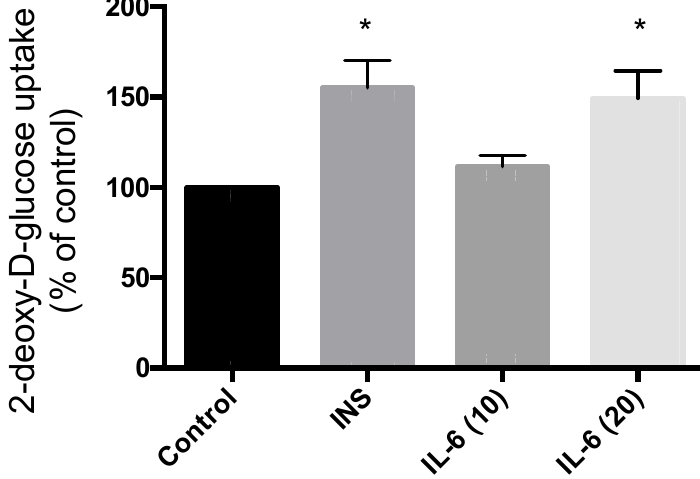
Figure 5. Effect of Acute IL-6 and Insulin Treatment on Neuronal Cell Glucose Uptake. SH-SY5Y cells were treated with 100 nM insulin, 10 ng/mL, or 20 ng/mL IL-6 for 30 min followed by glucose uptake measurements. Acute insulin and IL-6 (20 ng/mL) treatment significantly increase glucose uptake (CON, n = 4; INS, n = 4; IL-6 (10), n = 6; IL-6 (20), n = 6). Data are presented as mean ± SE of 6 independent experiments, expressed as percent of control * p ≤ 0.05, as determined using a one-way ANOVA followed by Fisher’s LSD post hoc analysis.